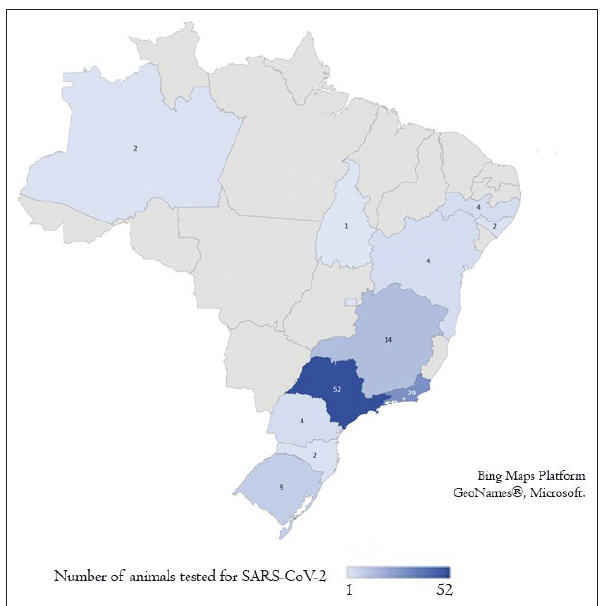
Figure-1: Origin and number of samples tested from each state of Brazil [Source: